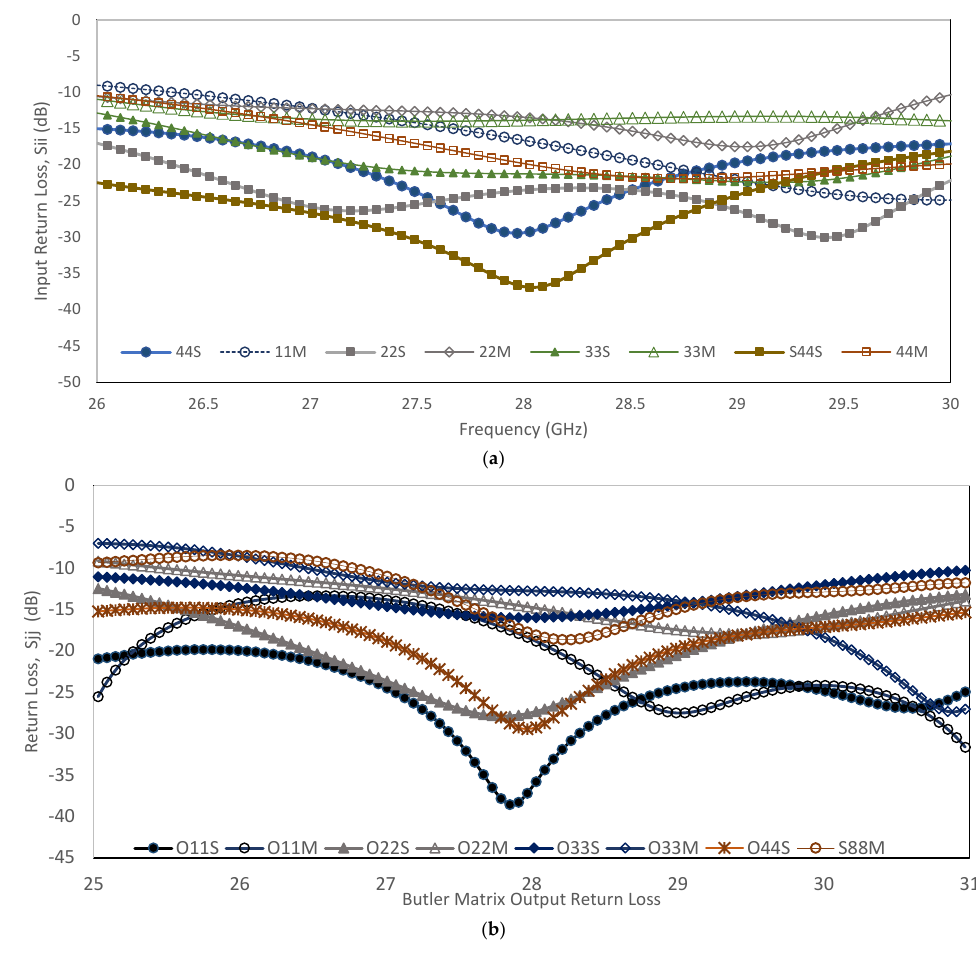
Figure 24. Return loss simulation and measurement results: ( a ) input ports, P1 till P4; ( b ) output ports, O1 till O4. The output power to input power ratio is represented by the transmission amplitude with the theoretical value of ‒ 6 dB. For improved comparison, the simulation and meas- urement values of transmission amplitude are plotted in Figure 25. The amplitude simu- lation with the extended line shows the range from ‒7.2 dB to ‒9.3 dB, while the measure- ment shows the range from ‒8.2 dB to ‒10 dB. The imbalanced transmission amplitude measurement has an average deviation of 1.38 dB compared to the simulation values. The variation of the transmission amplitude from the ideal value of −6 dB is due to the exten- sion of the additional strip line. The strip line loss (referring to Figure 6) has line loss offset